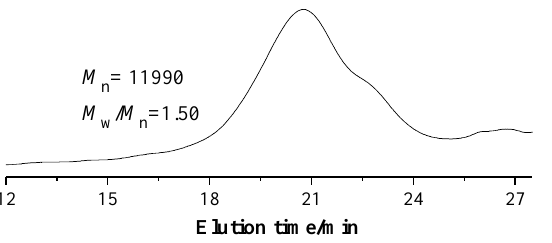
Figure 1. GPC trace of PMAAAB- ran -P(THP-HEA) ( F MAAAB = 0.5351).